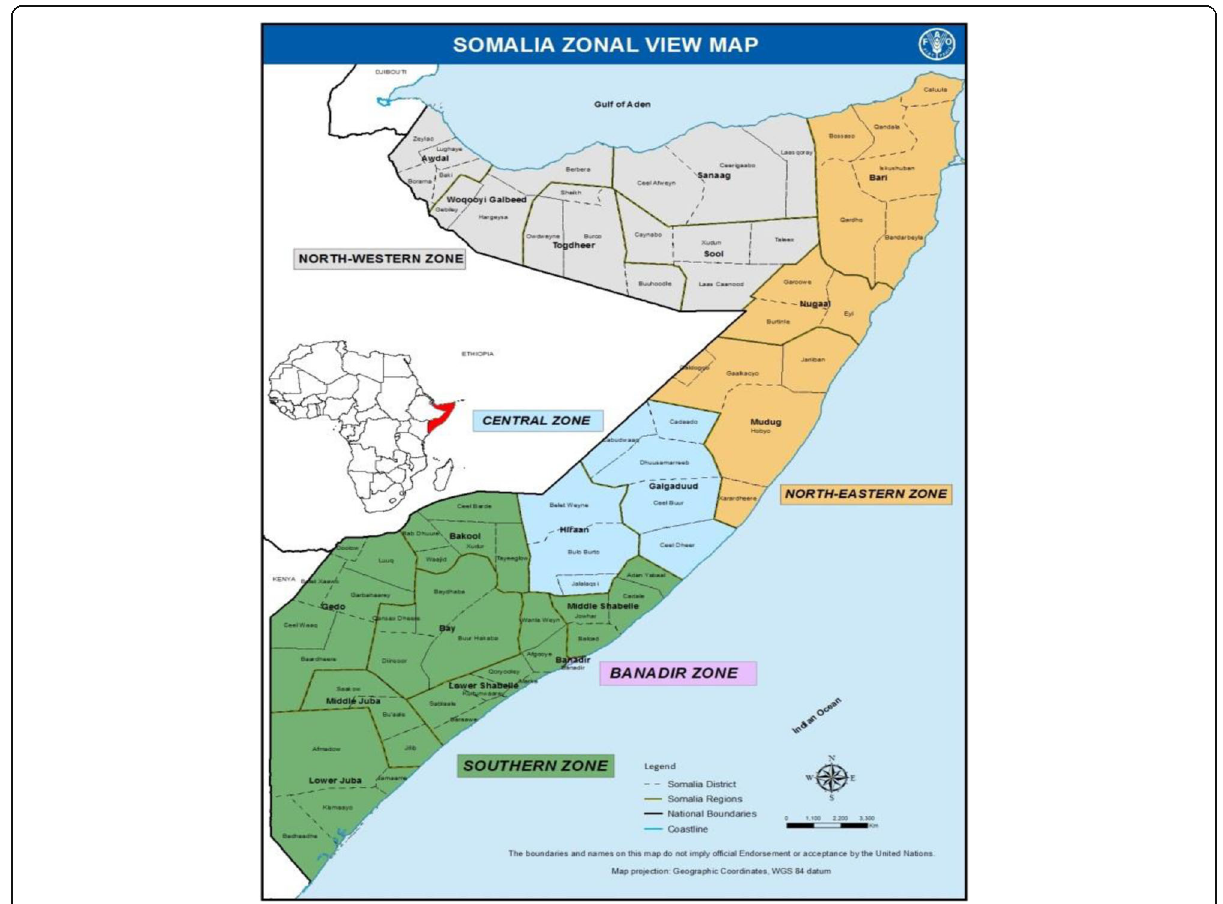
Figure 1 Map of Somalia showing the different